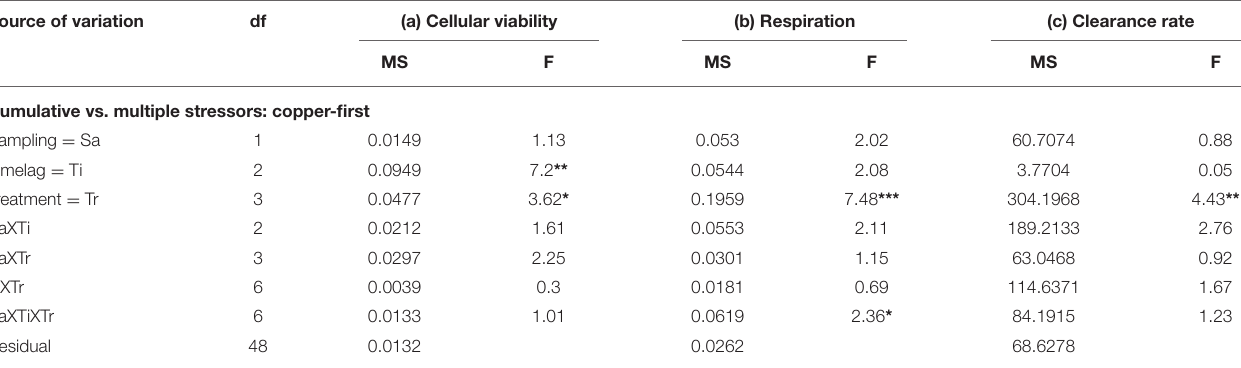
TABLE 2 | Analyses of the (a) cellular viability (optical density g − 1 haemocyte protein), (b) community respiration (mg O 2 l − 1 h − 1 ), and (c) clearance rates (l/h) of mussels/mussel assemblages at Malahide marina comparing cumulative and multiple stressor treatments with copper as the primary stressor, corresponding to the first and second subsets of treatments described in the Materials and Methods ( n = 3 plots; for all variables: data are untransformed; Cochran’s test: ns). Source of variation df